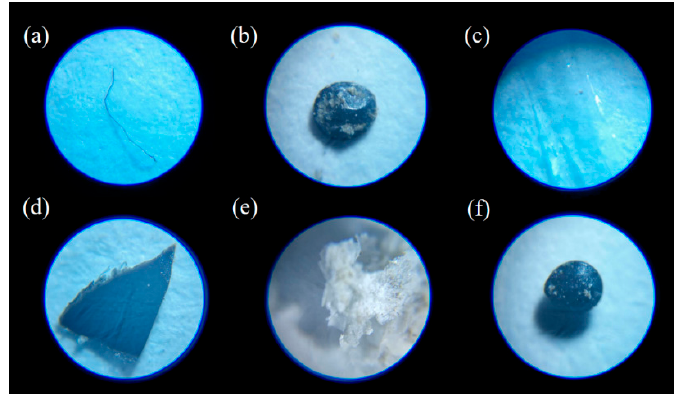
Figure 7 . Different shape of MPs detected in this study including ( a ) fibers, ( b ) pellets, ( c ) films, ( d ) fragments, ( e ) foams, and ( f ) microbeads.